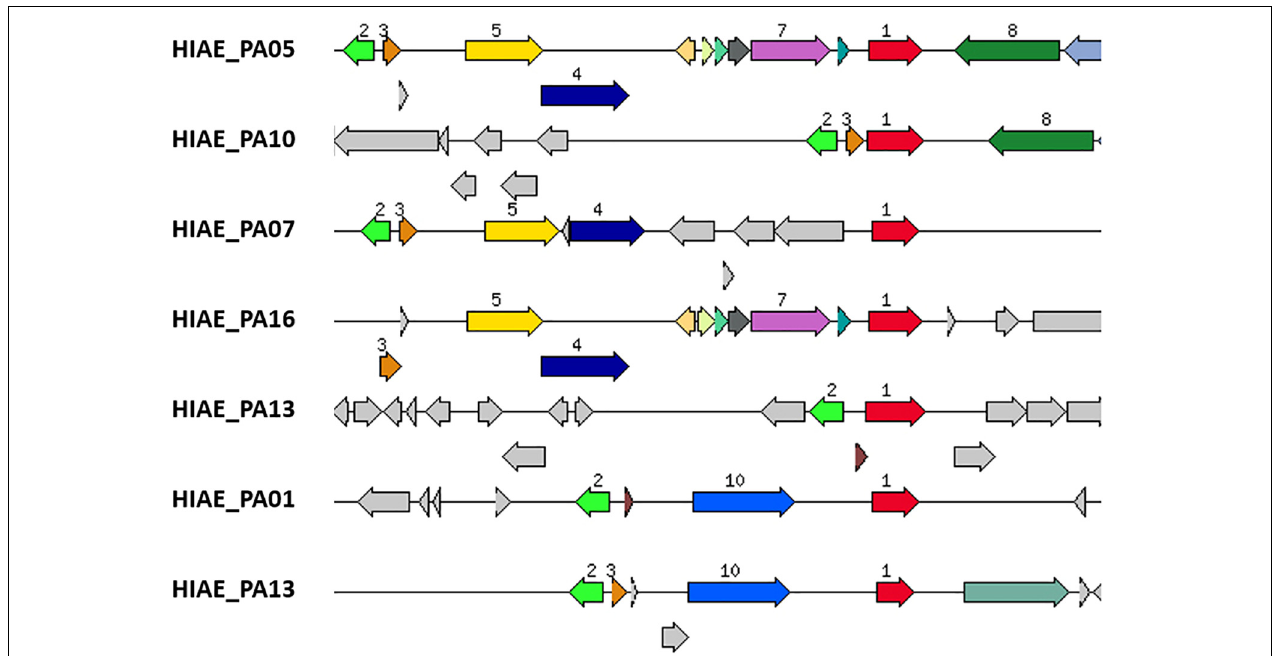
FIGURE 4 | Genomic region of umuC -carrying strains of P. aeruginosa. The gene encoding an UmuC homolog is highlighted in red (number 1); it is present in six strains (strain HIAE_13 has two copies). UmuD-like sequences (orange, number 3) are present in close vicinity in five of these six strains. Only strain HIAE_10 carries a putative umuCD operon. In all six strains, the umuCD -containing region is strain-specific. Some adjacent genes are shared in two or more strains, encoding a Gifsy-2-prophage protein (light green, number 2), a recombinase/phage integrase (dark blue, number 4), a hypothetical protein (yellow, number 5), a DNA/RNA helicase (dark green, number 8), a mobile element protein (light blue, number 10). Interestingly, in two strains, a gene encoding a mercury resistance protein (violet, number 7) is closely associated with umuC